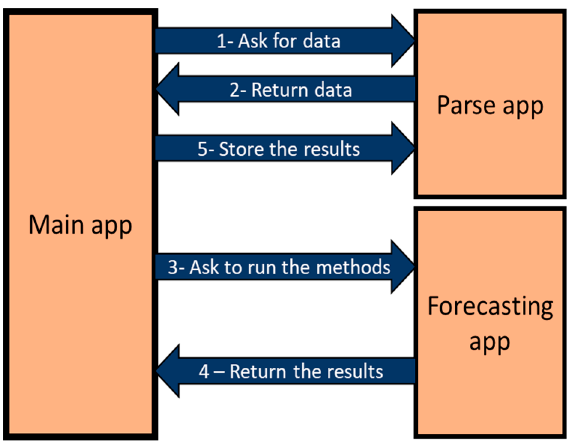
Figure 4. A generic model of the implementation.